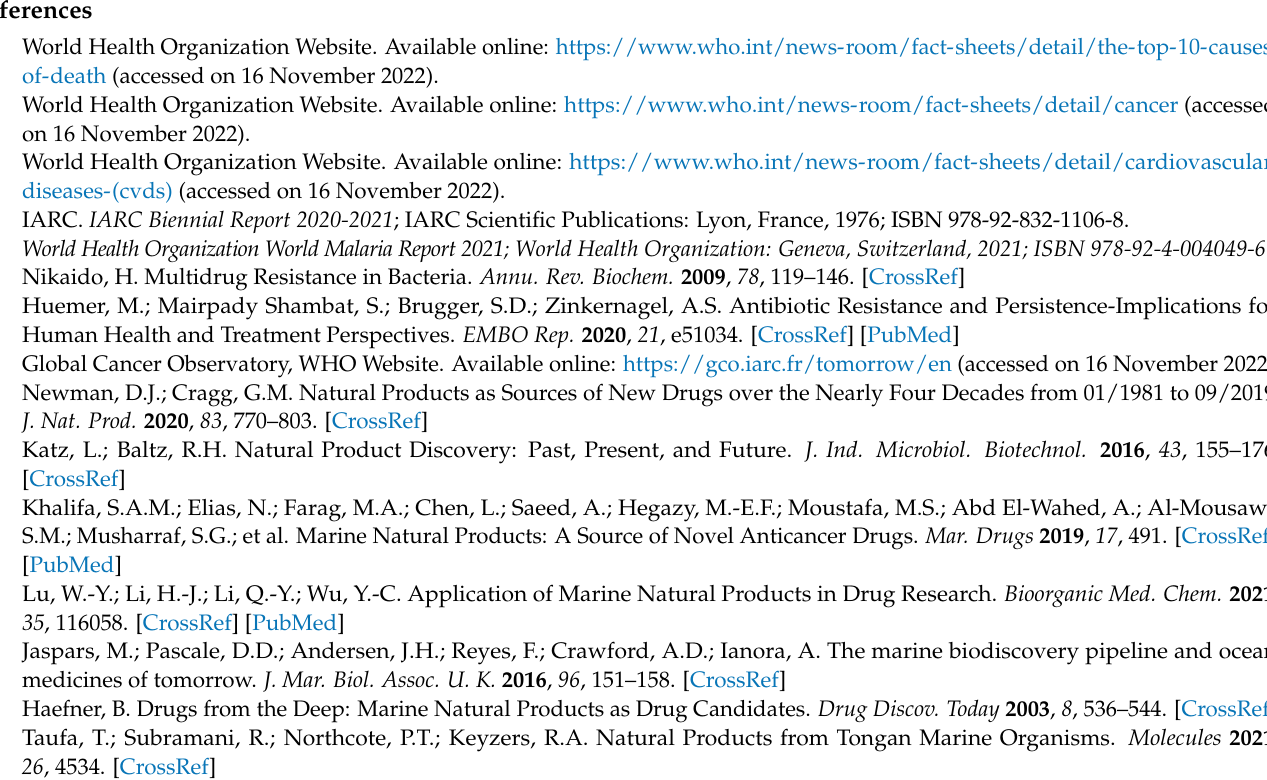
Figure S3: Cluster of Micromonospora fluostatini SH-82’s extract (red node) containing dicharged and monocharged ions; Figure S4: MS1 compounds C.1.20; 6-Deoxyerythronolide B (C21H38O6) m/z 369.2624; RT: 8.25 min; Best adduct: [M-H2O+H]+; Figure S5: Cluster of Salinispora arenicola SH-78 (purple node) not accurately annotated; Table S1: Batch mode use for data processing with MZMine 3.; Table S2: Summary table of peaks observed in the chromatographic profiles HPLC-CAD for each microbial extract; Table S3: Detailed table of chemical, biological and novelty scores for